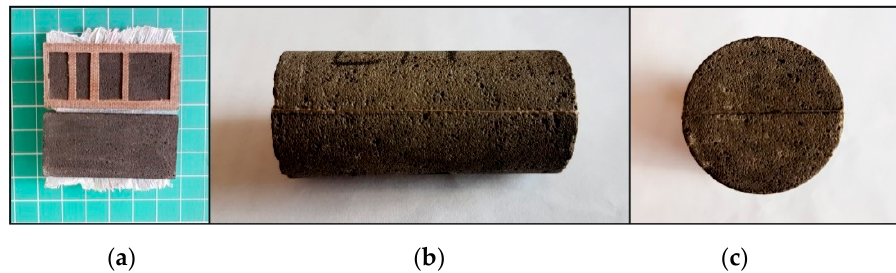
Figure 3. The geometry of the fracture in the composite core. As a result, the changes in the pore volume of each core associated with slabbing and creation of artificial fracture were meticulously taken into account in the balance of injected and recovered fluids. The measurement of permeability before and after artificial fracturing allowed us to determine the fracture permeability. This turned out to be more than 10 times higher than the permeability of the matrix. Other composite core parameters have changed very slightly (Table 5). Table 5. Properties of composite cores with the artificial fracture. Properties of Fractured Core